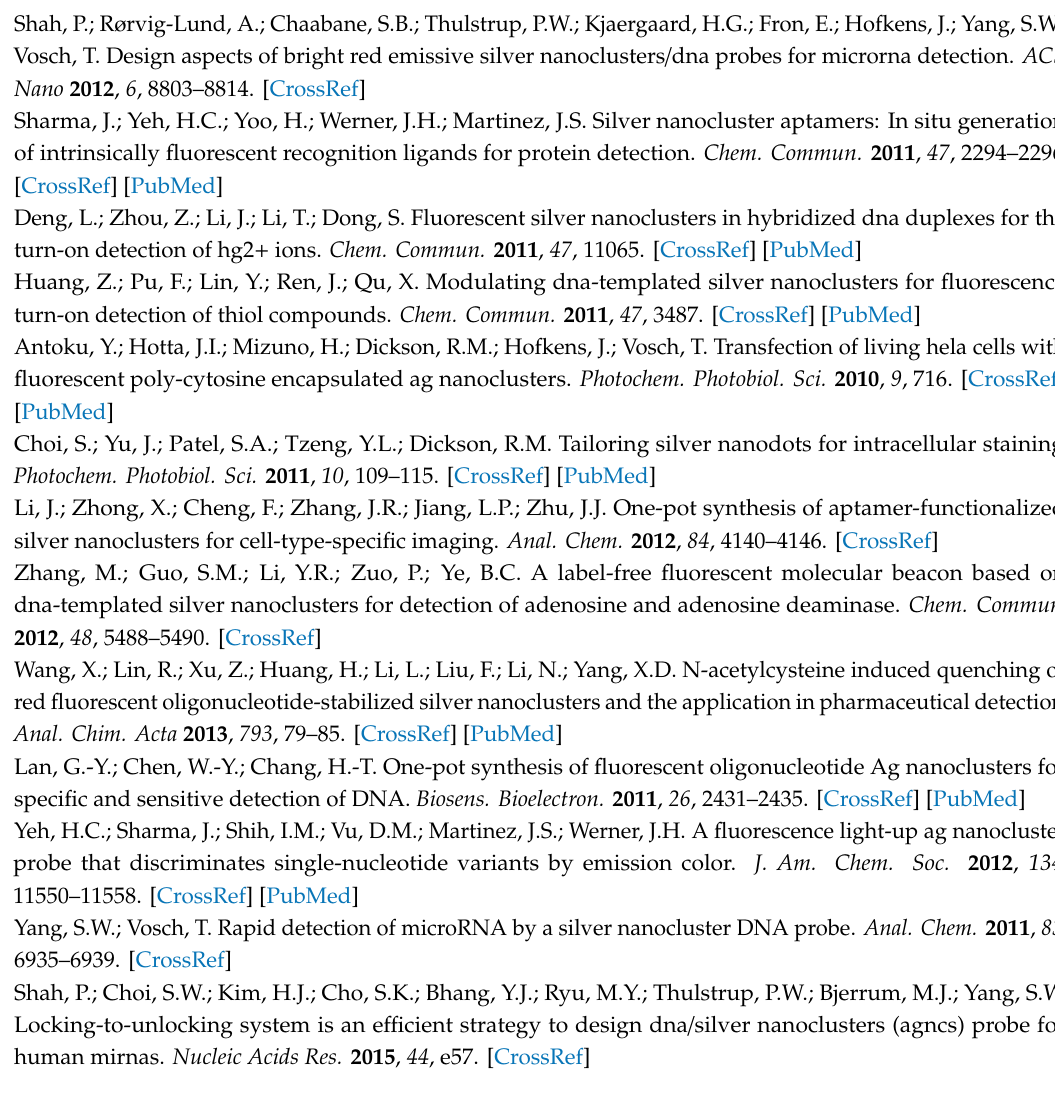
Figure S1: Eppendorf tube images under UV (Ex 365 nm) illumination. All the samples were prepared on day 0 and were taken just after and hour of synthesis before storing for long term studies. (A) DNA 6C-27a-3bp / AgNCs and (B) DNA 6C-217-11bp / AgNCs. Figure S2–S9: full scan emission profile of DNA 6C-27a-3bp / AgNCs and DNA 6C-217-11bp / AgNCs on 0, 1, 2, 4, 8, 11, 18- and 23-days post-synthesis of